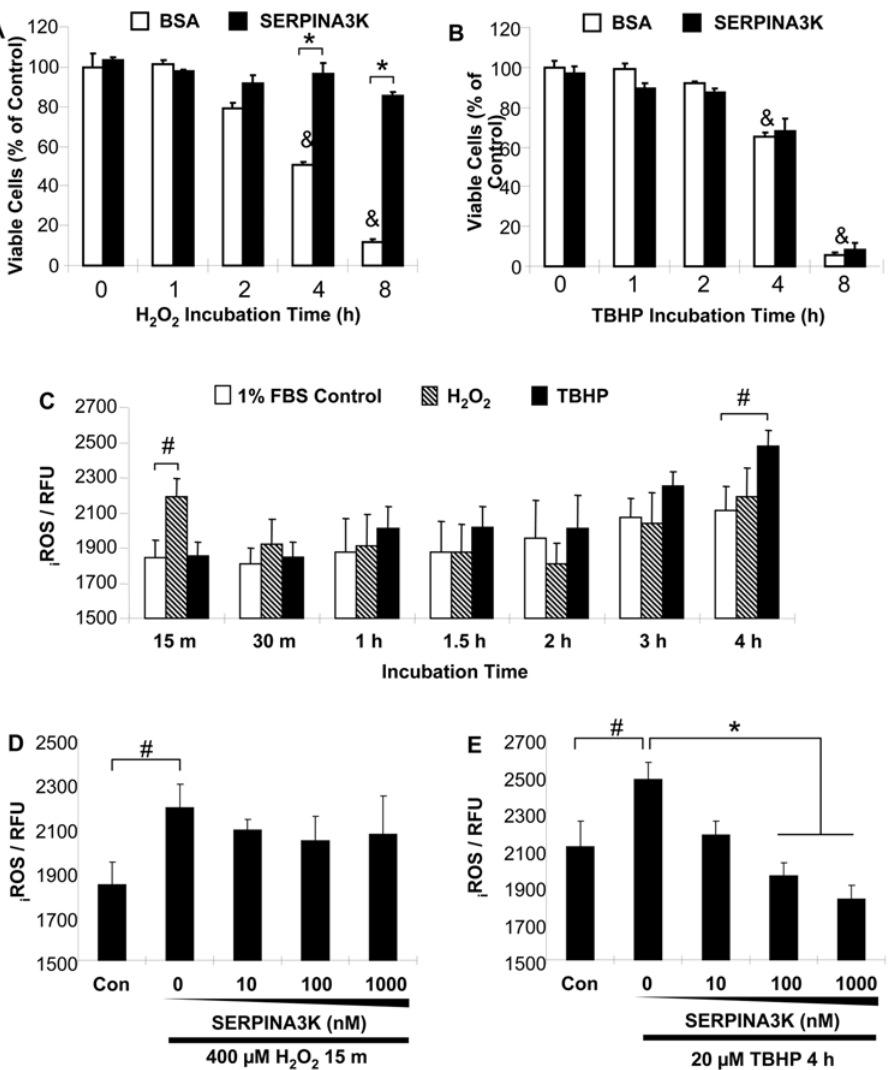
Figure 3. Lack of effect of SERPINA3K on the intracellular ROS generation in cells exposed to H 2 O 2 . ( A, B ) The rMC-1 cells were treated with 400 m M H 2 O 2 ( A ) or 20 m M TBHP ( B ) for 1, 2, 4 and 8 h in the absence or presence of 1 m M BSA or SERPINA3K. Viable cells were quantified using MTT assay (mean 6 SEM, n=3). ( C ) The rMC-1 cells were exposed to 400 m M H 2 O 2 or 20 m M TBHP for various durations as indicated, to define the time point for the ROS increase. Note that ROS levels were elevated by H 2 O 2 as early as 15 min, while the ROS generation induced by TBHP occurred at 4 h of the treatment. ( D&E ) rMC-1 cells were pre-treated with various concentrations of SERPINA3K for 1 h. The medium was supplemented with BSA to the same total protein concentration in each well. The cells were then exposed to 400 m M H 2 O 2 for 15 min ( D ) or to 20 m M TBHP for 4 h ( E ). The intracellular ROS generation was measured using CM-H2DCFDA as a probe. Values are arbitrary fluorescence units (mean 6 SEM, n=8). SERPINA3K blocked the ROS increase induced by TBHP but not that by H 2 O 2 . * P , 0.01, the SERPINA3K-treated cells versus the BSA-treated cells. & P , 0.01, the BSA-treated cells exposed to H 2 O 2 versus the BSA-treated cells without H 2 O 2 exposure. # P , 0.05, the H 2 O 2 or TBHP-treated cells versus control cells.